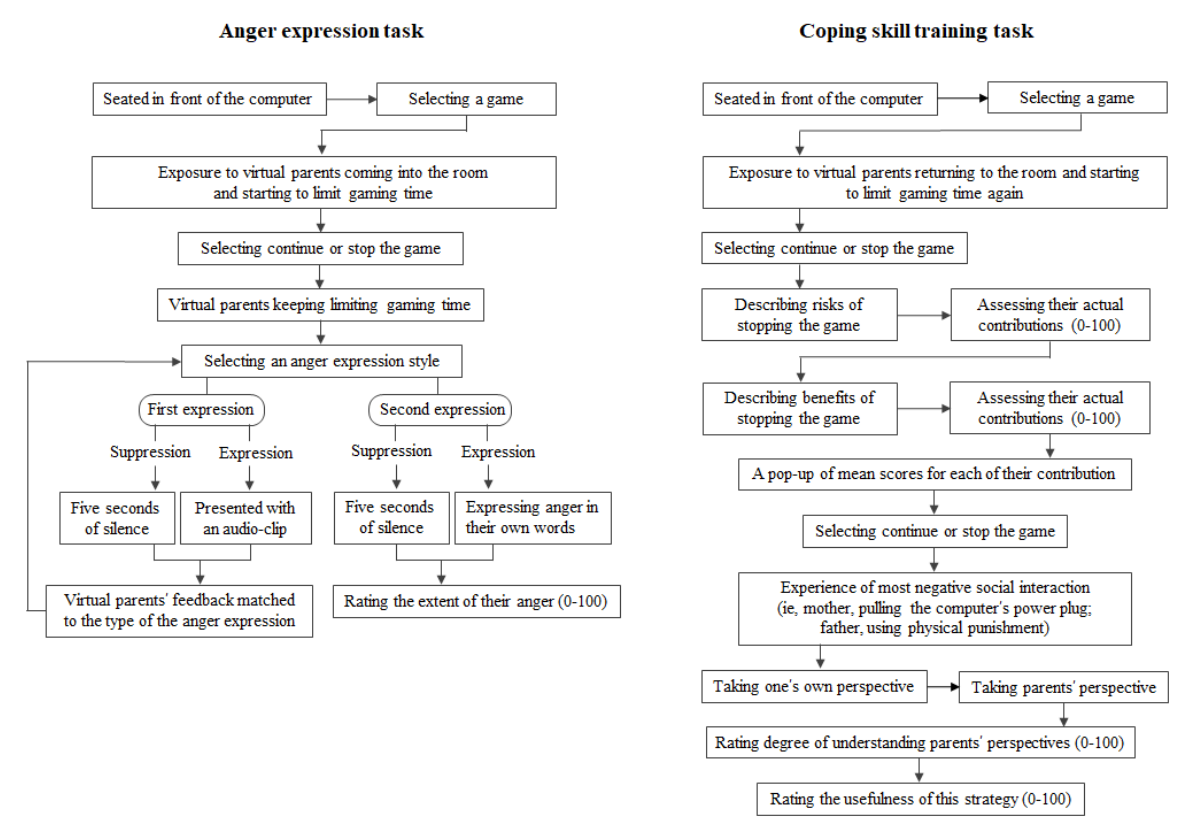
Figure 3. Flowchart of the virtual reality